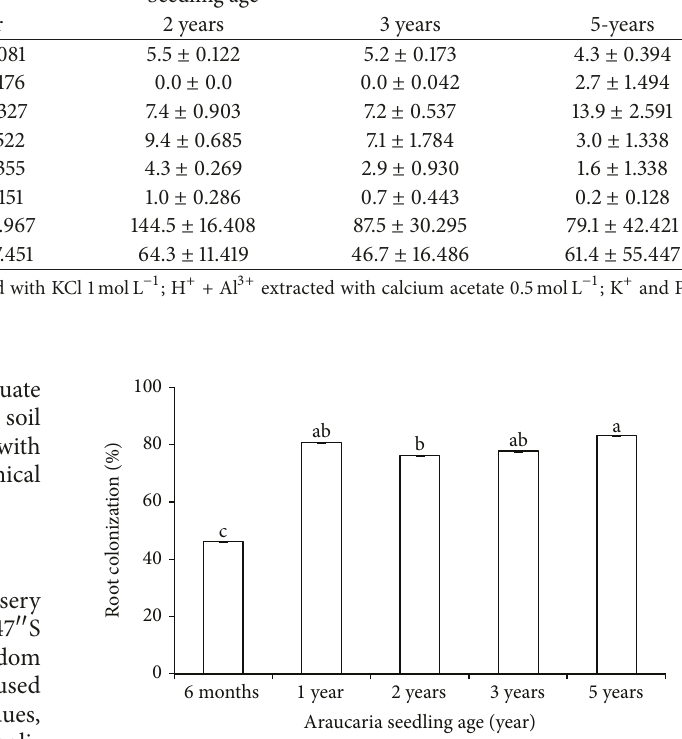
Table 1: Chemical attributes of soils used in the nursery experiment with araucaria in Curitiba, Brazil. Soil attribute ∗